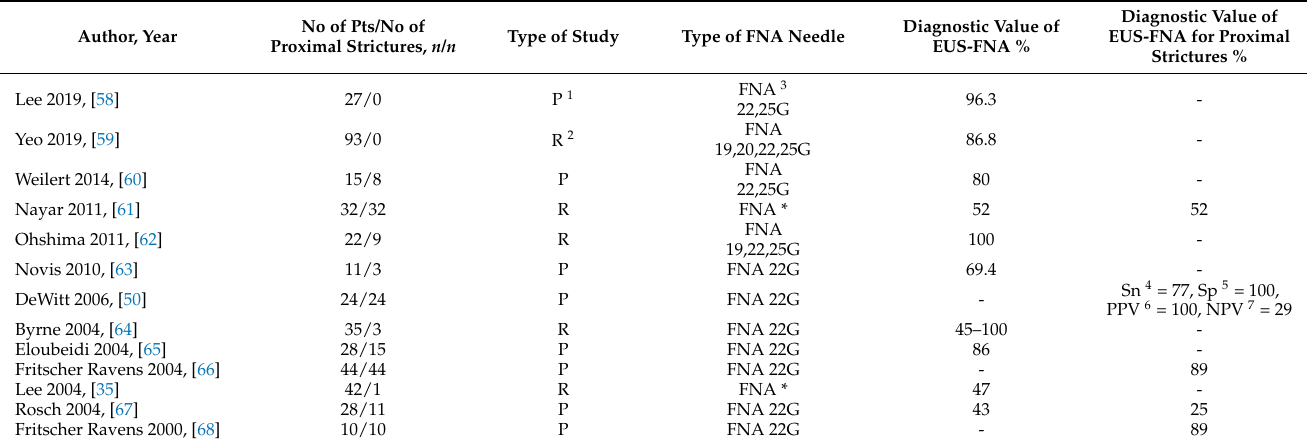
Table 2. Diagnostic value of endoscopic ultrasound fine needle aspiration of biliary strictures. Type of Study Type of FNA Needle Diagnostic Value of EUS-FNA %